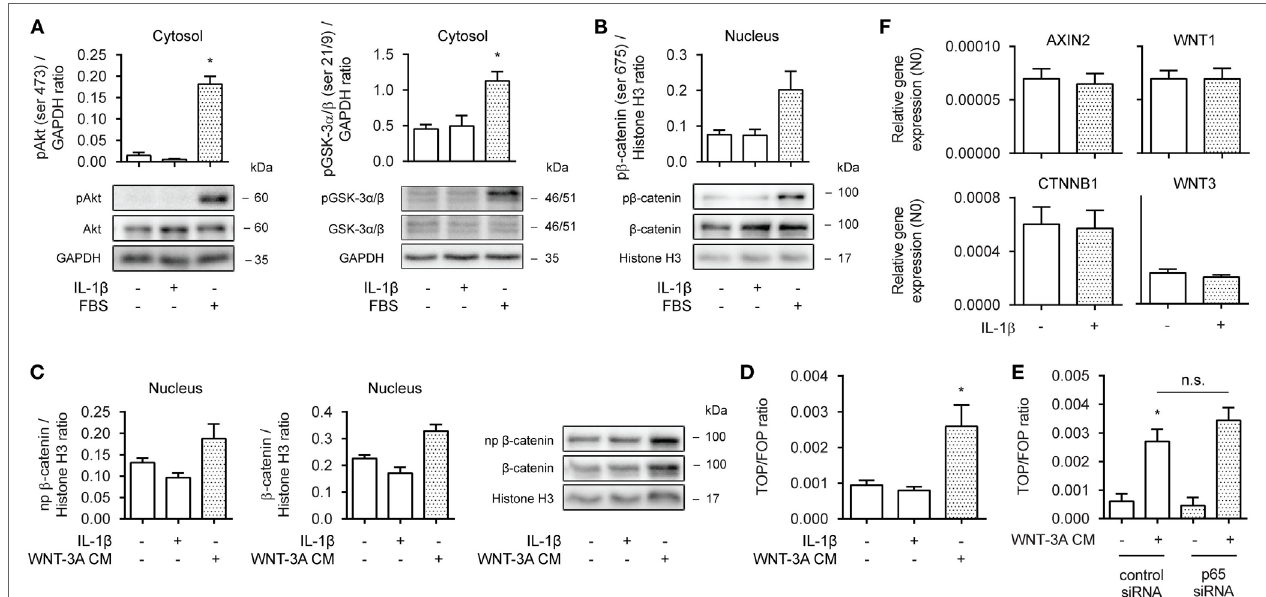
FigUre 2 | Interleukin-1 β (IL-1 β ) does not promote WNT/ β -catenin signaling. (a) Cytosolic extracts were used to immunoblot phospho (ser 473) Akt (left panel) and phospho (ser 21/9) glycogen synthase kinase (GSK)-3 α / β (right panel) and normalized against GAPDH. Cells were treated with IL-1 β (1 ng/mL) or fetal bovine serum (FBS) (10% v/v) for 30 min. Data represent four independent experiments. (B) Nuclear extracts were used to immunoblot phospho (ser 675) β -catenin as in (a) . Data represent three independent experiments. (c) Nuclear extract immunoblot of non-phospho (active) β -catenin and total β -catenin, normalized to Histone H3. Cells were treated with IL-1 β (1 ng/mL) or WNT-3A conditioned medium (100%) for 16 h. Data represent three independent experiments. (D) TOPFlash reporter assay of human airway smooth muscle cells exposed to IL-1 β (1 ng/mL) or WNT-3A conditioned medium (100%) for 24 h. Data represent four independent experiments. (e) TOPFlash reporter assay of human airway smooth muscle exposed to WNT-3A conditioned medium (100%) while transiently transfected with 30 pmol control or p65 small-interfering RNA (siRNA). Data represent seven independent experiments. (F) mRNA of airway smooth muscle cells exposed to IL-1 β (1 ng/mL) for 24 h was isolated and subjected to RT-qPCR for canonical WNT-target genes. Data represent three independent experiments. * vs.